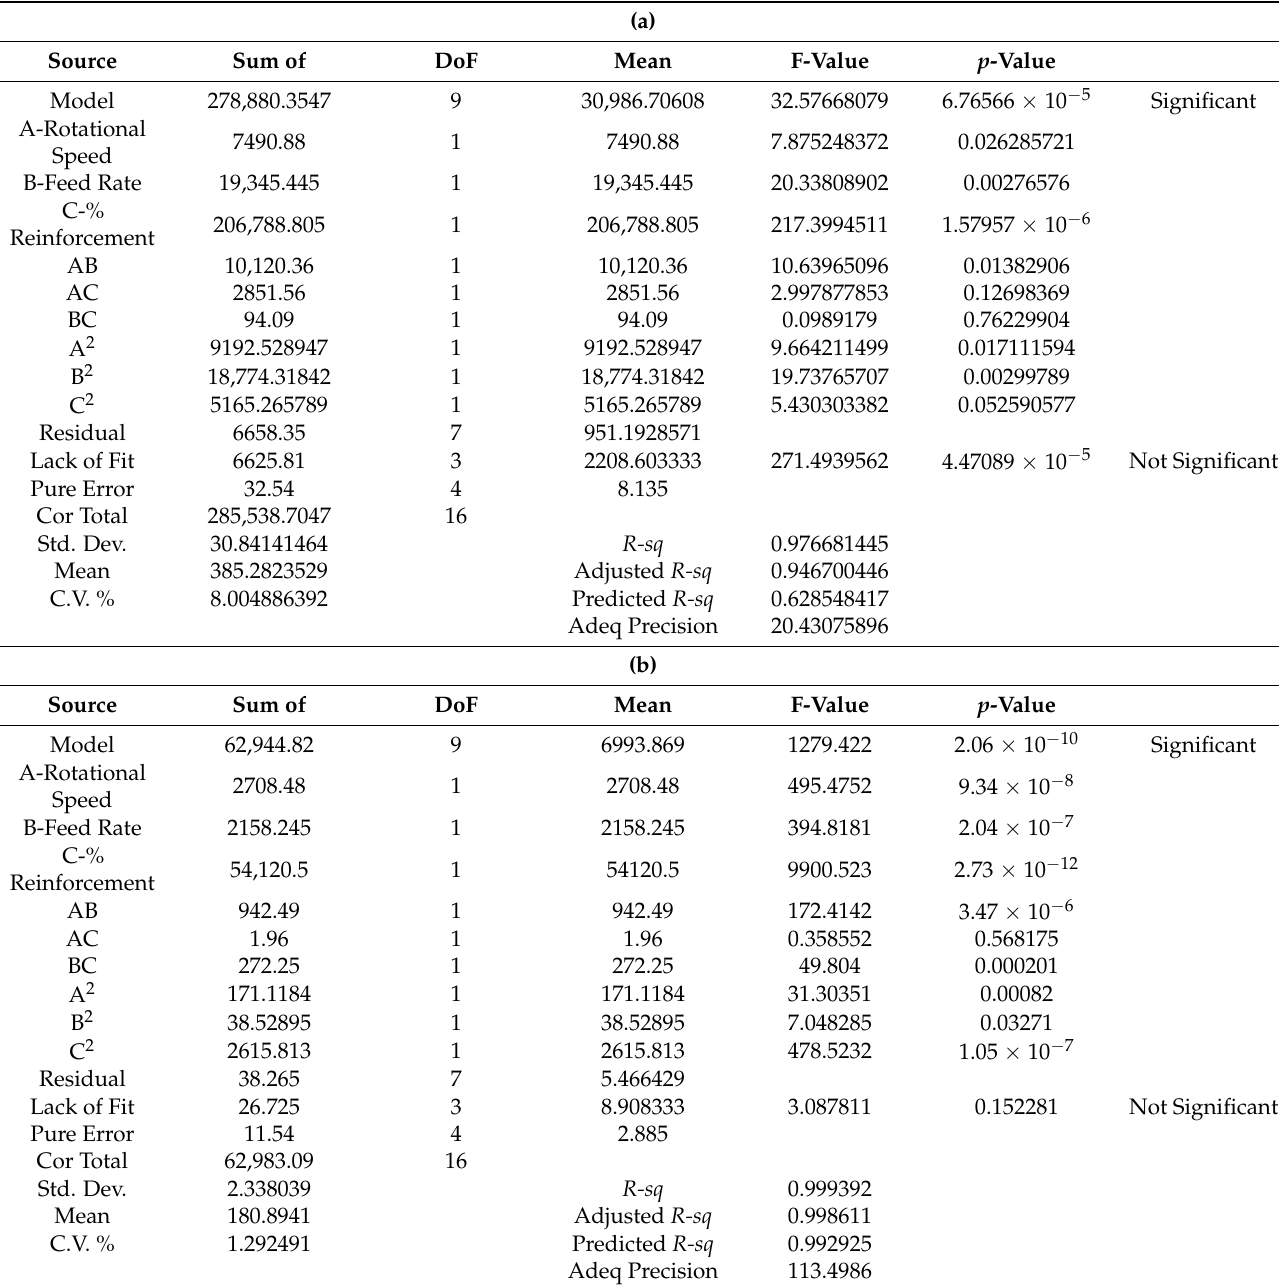
Table 4. ( a ) ANOVA analysis on the effect of input variables on thrust force. ( b ) ANOVA analysis on the effect of input variables on